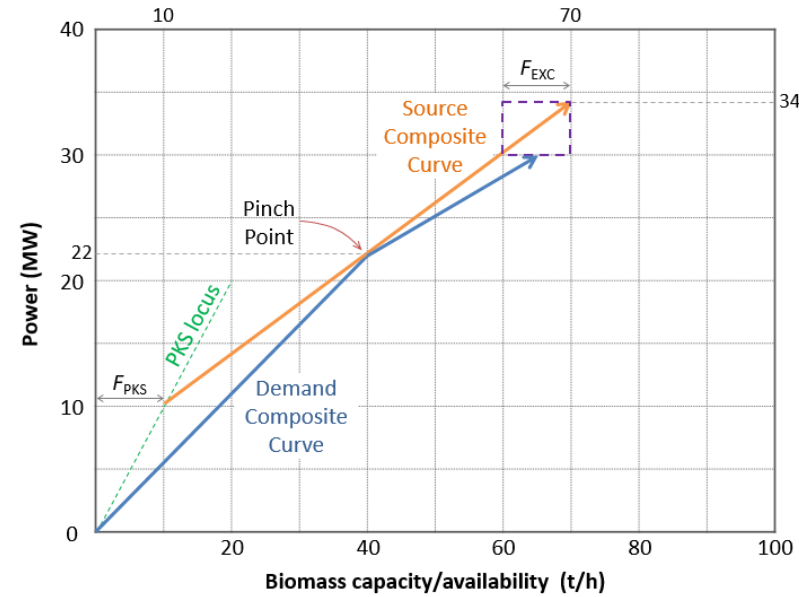
Figure 6. BEPD with minimum PKS.